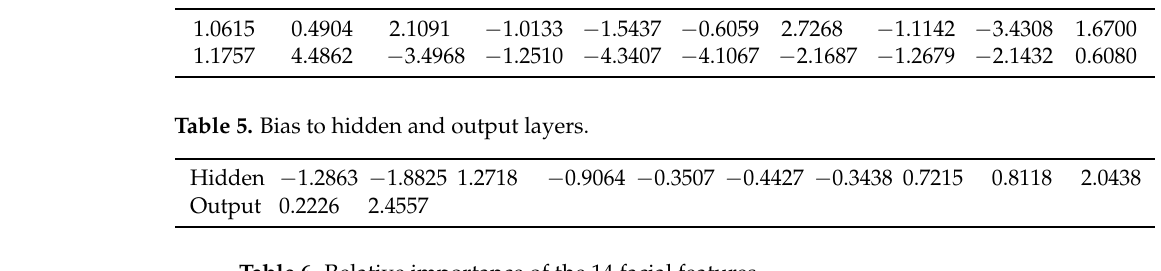
Table 4. Weight matrix between hidden and output layers (